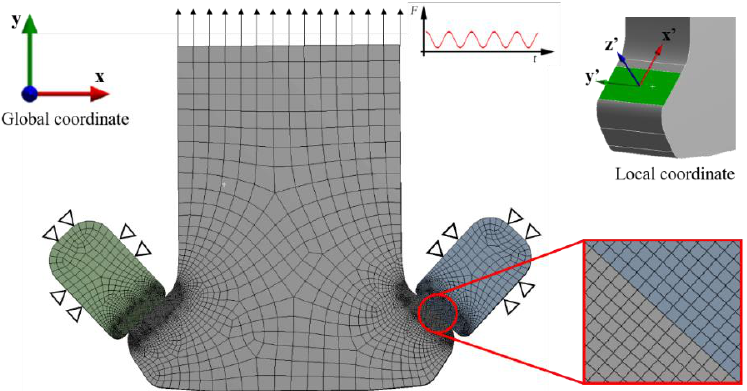
Figure 5. Mesh and boundary conditions.